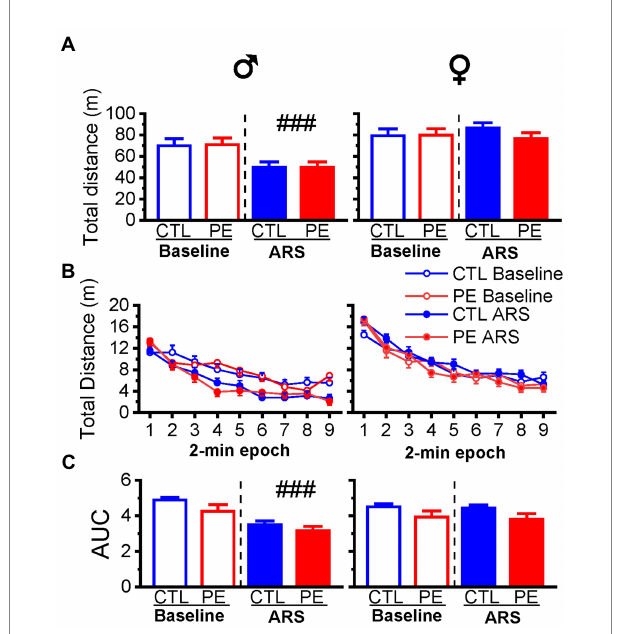
FIGURE 3 Effects of prenatal ethanol exposure (PE) on locomotor activity and its habituation under higher ambient light (60 lux). Prenatal ethanol exposure did not impact total distance travelled under the basal condition (A,B) . In males, acute restraint stress (ARS) decreased total distance travelled in the OF. Prenatal ethanol exposure did not alter habituation of the locomotor activity in the OF in either sex (C) . Acute restraint stress facilitated the habituation of locomotor activity shown as reduced value of area under the curve (AUC). Data are represented as Mean ± SEM. ### p < 0.001, baseline condition vs. ARS. CTL,